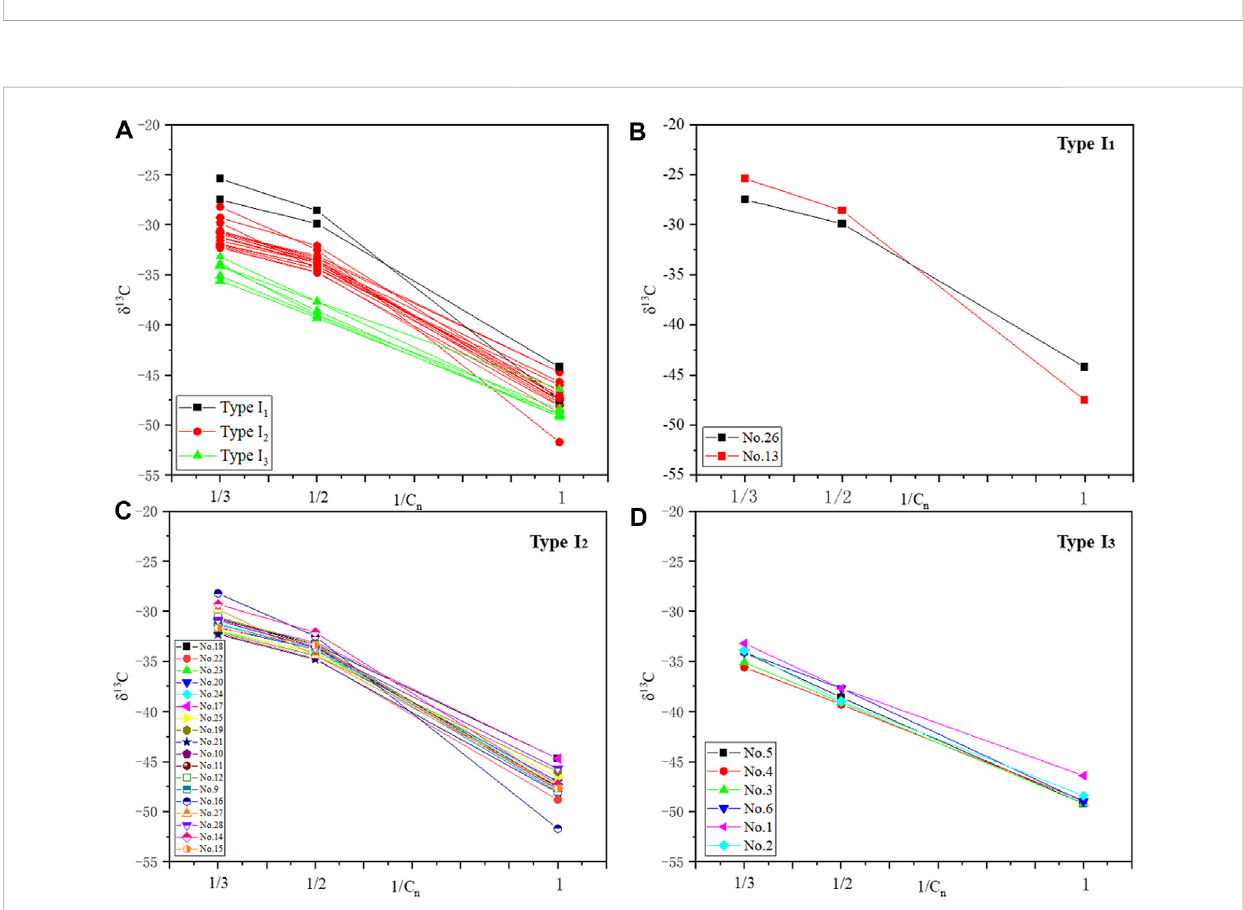
FIGURE 5 Relationship between carbon number 1/n and δ 13 Cn of natural gases in Shunbei (A) Classi fi cation of natural gas types in Shunbei and (B) Type I 1 natural gases and (C) Type I 2 natural gases and (D) Type I 3 natural gases (Modi fi ed from Chung et al., 1988; Dai et al., 2003).